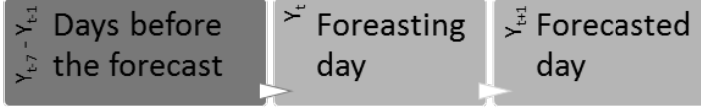
Figure 2. Day-ahead forecasting